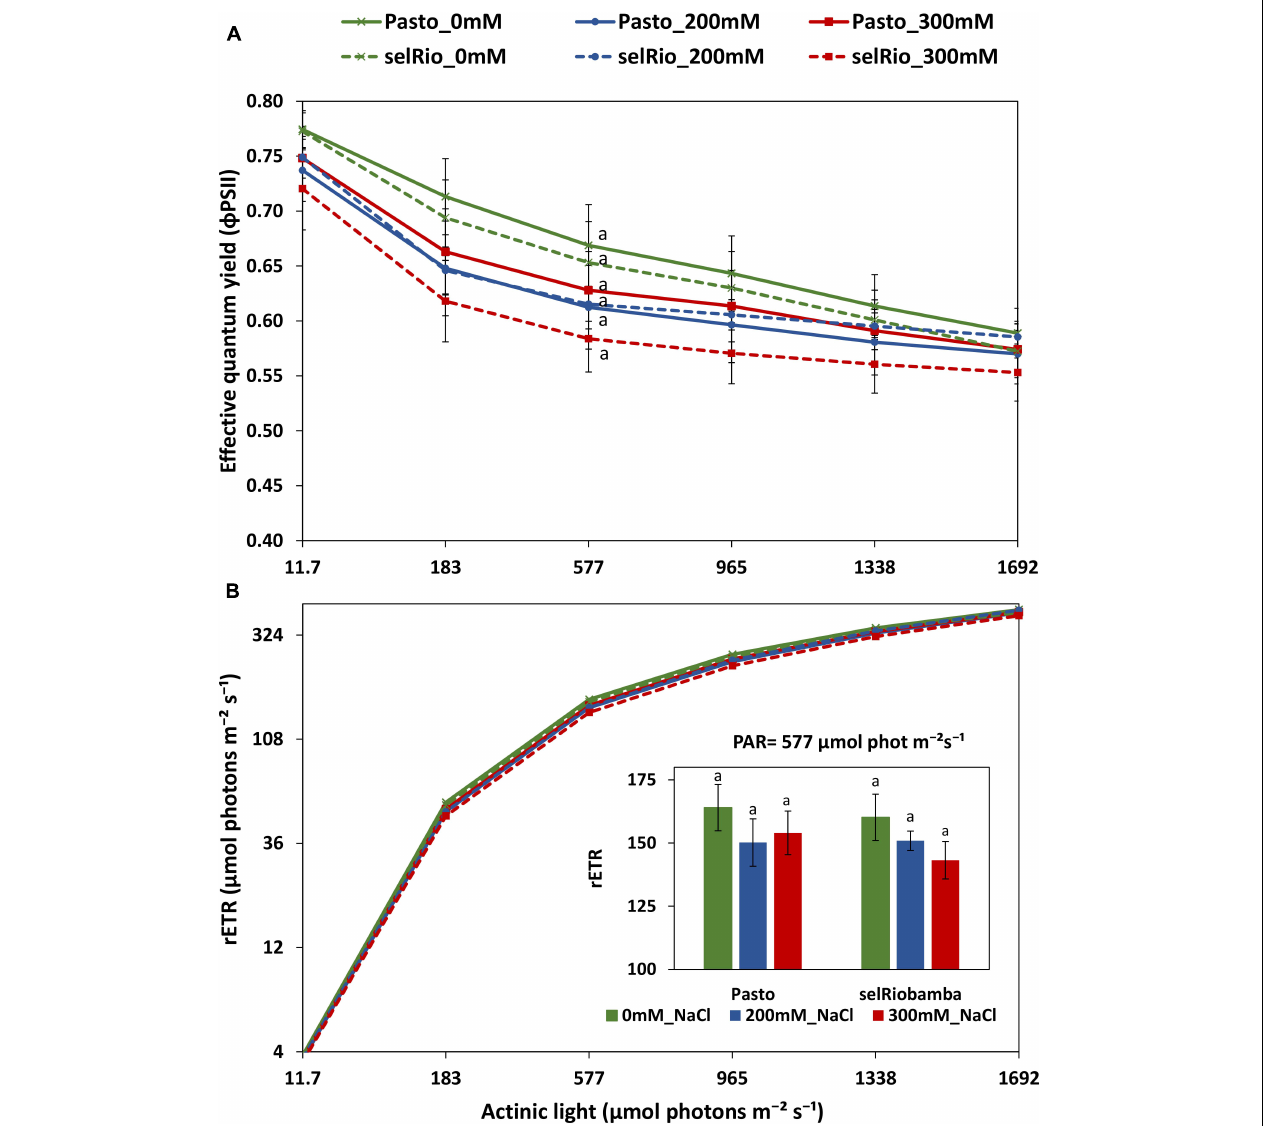
FIGURE 7 | Derived parameters of a rapid light curve from light adapted detached young leaves of quinoa. (A) Effective quantum yield as a function of PAR. (B) Relative electron transfer rate as a function of PAR. Means of 4 plants. Error bars indicate SE of individual means. Statistically significant differences ( p ≤ 0.05) between any variety and salt treatment combination are shown with different